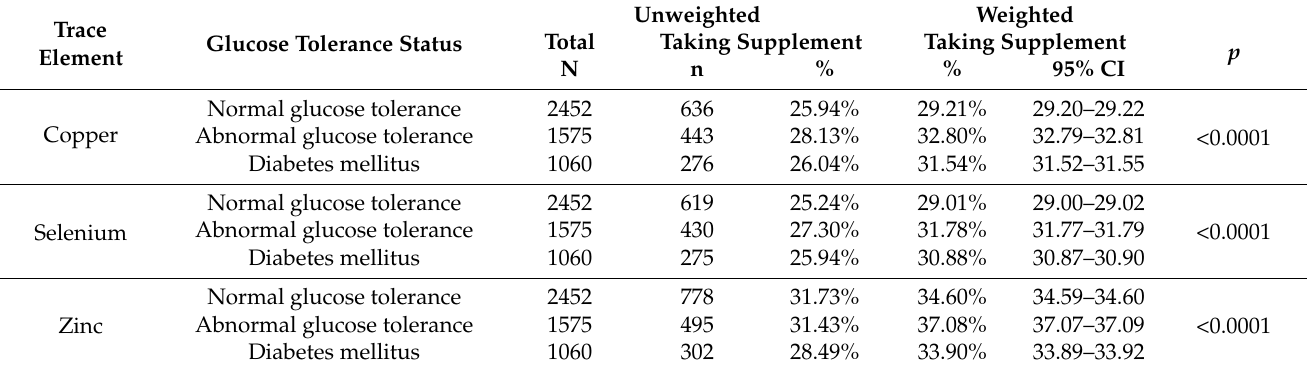
Table 5. Daily supplement of copper, selenium, and zinc by the states of glucose tolerance. Trace